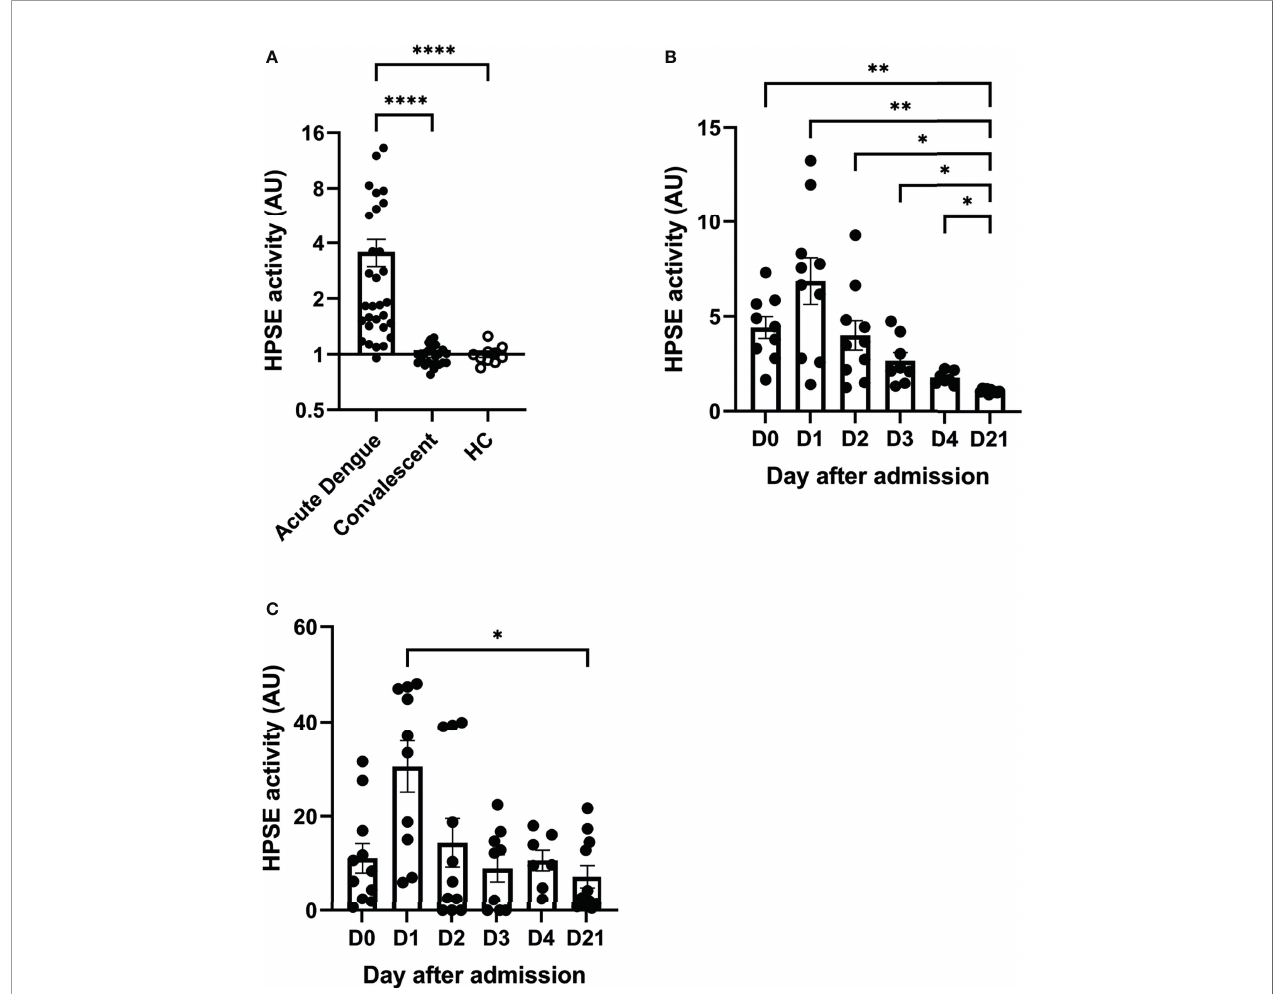
FIGURE 1 | Acute dengue patients display increased plasma and urine HPSE activity. (A) HPSE activity in plasma of dengue patients in acute (day 0 or 1 upon hospitalization, n=30) and convalensent (n=25) phase compared to healthy controls (n=10). (B) HPSE activity in plasma of acute dengue patients over time (n=10). (C) HPSE activity in urine of acute dengue patients over time (n=11). Data were presented as mean ± SEM and tested for normal distribution with D ’ Agostino & Pearson omnibus normality test. Statistical differences were calculated using mixed-model analysis followed by Bonferroni multiple comparison test or Kruskal-Wallis test followed by Dunn ’ s multiple comparisons test (*p < 0.05, **p < 0.01, ****p < 0.0001). HPSE, heparanase; HC, healthy controls; AU, arbitrary units; D,